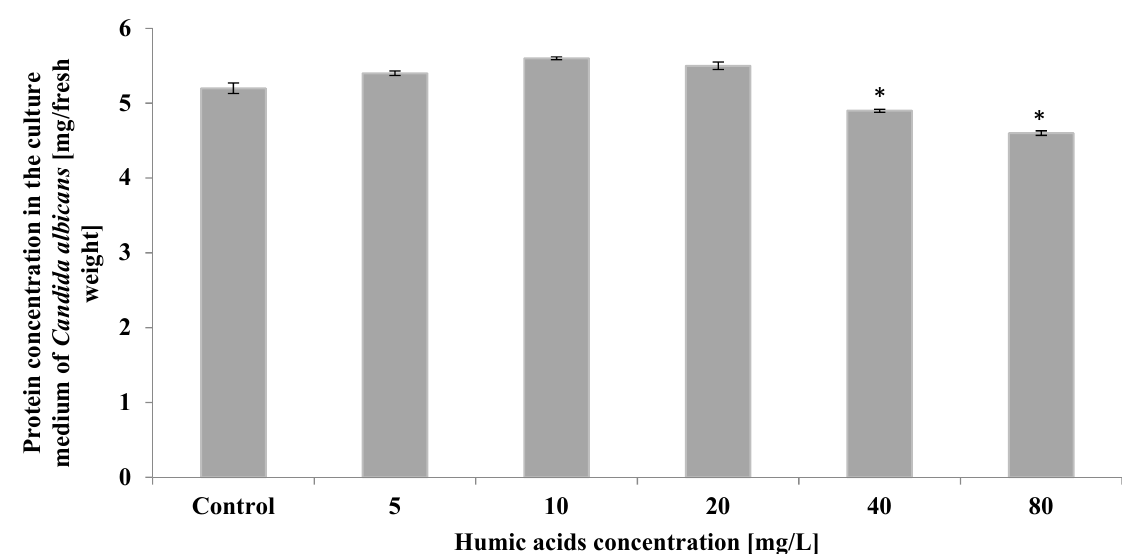
Figure 3. The effect of humic acids on the concentration of protein in the culture medium of Candida albicans on the 5th day of culture ( n = 8, average values ± SD, p ≤ 0.01), (*) shows statistically significantly different values in comparison with control sample.